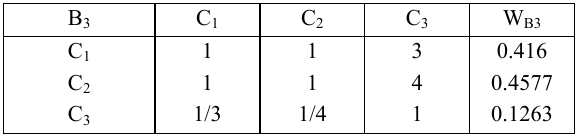
Table 4. The pairwise comparison matrix C 1-3 –B 3